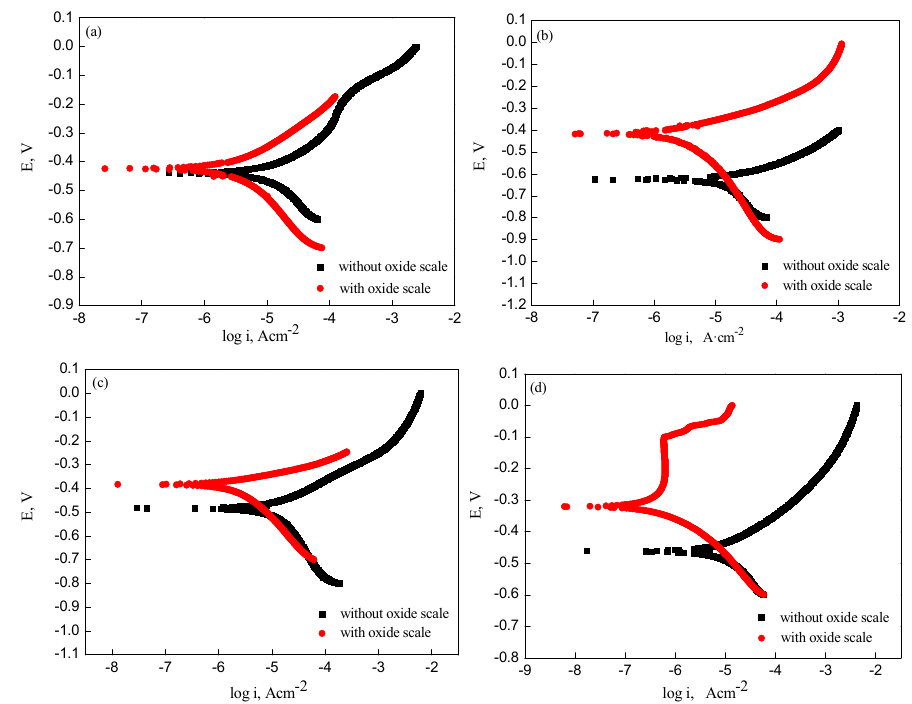
Figure 8. Potentiodynamic polarization curves of samples with and without oxide scale: ( a ) type I; ( b ) type II; ( c ) type III; ( d ) type IV.